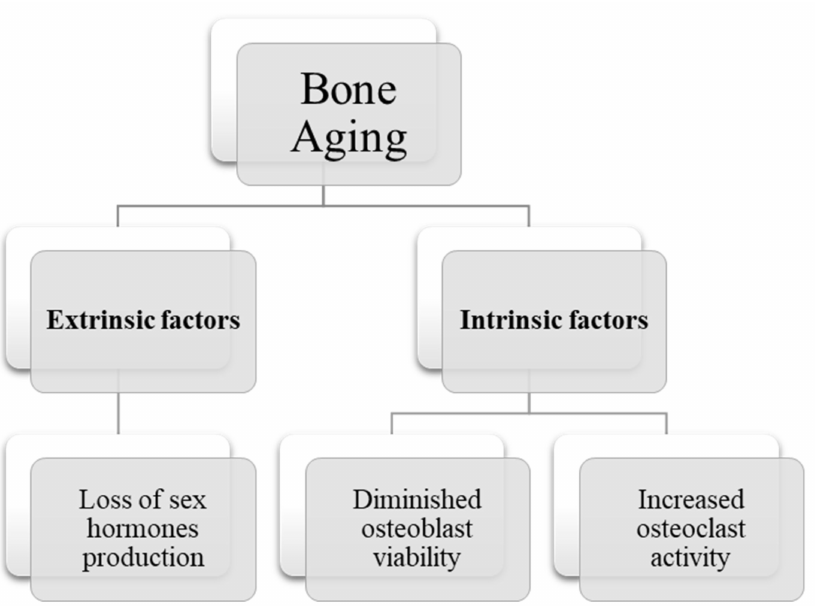
Figure 3. Summary of factors affecting aging-related pathophysiological changes in